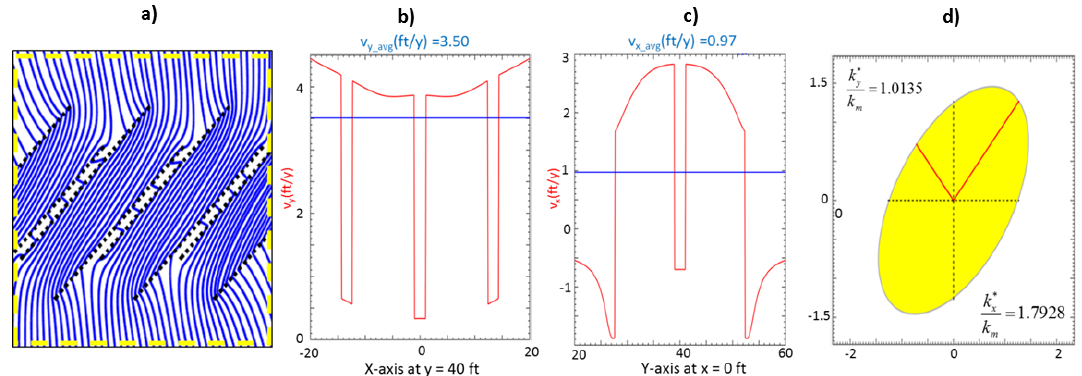
Figure A5. ( a ) Flow in a defined REV space with streamlines in blue and natural fractures (NF) in dashed black, ( b , c ) Velocity profiles along cross-hairs at y = +40 and x = 0, respectively, ( d ) Equivalent permeability ellipse based on Equations (A13) and (A14). Number of NF = 8; width of NF = 4ft; upscaled strength of NF = 240 ft 4 / year.